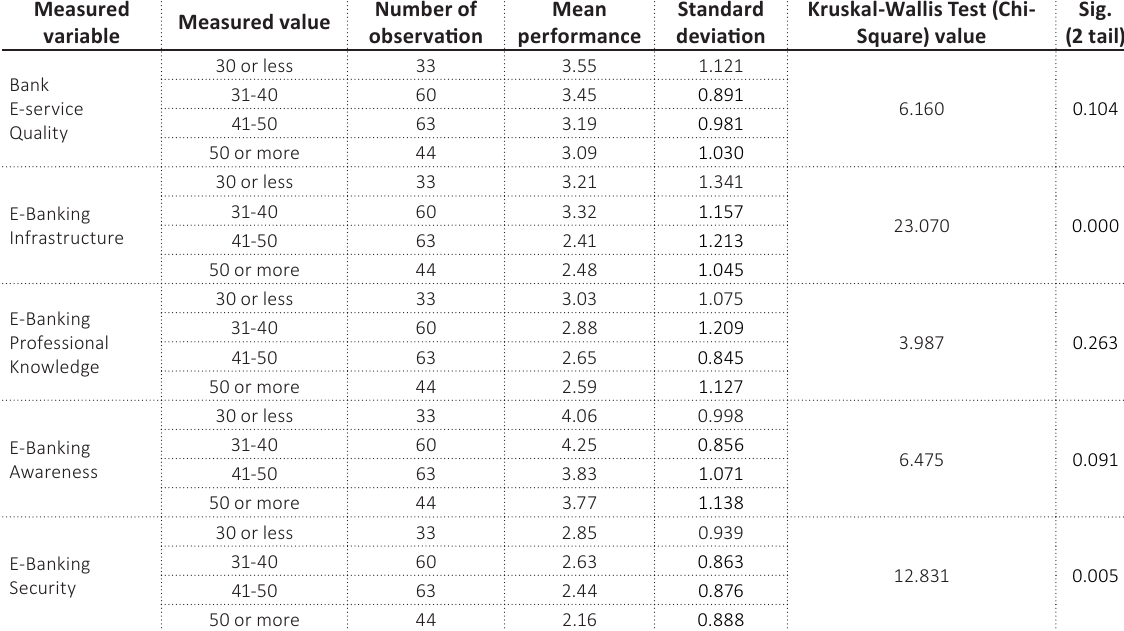
Table 4. Kruskal-Wallis test for age group